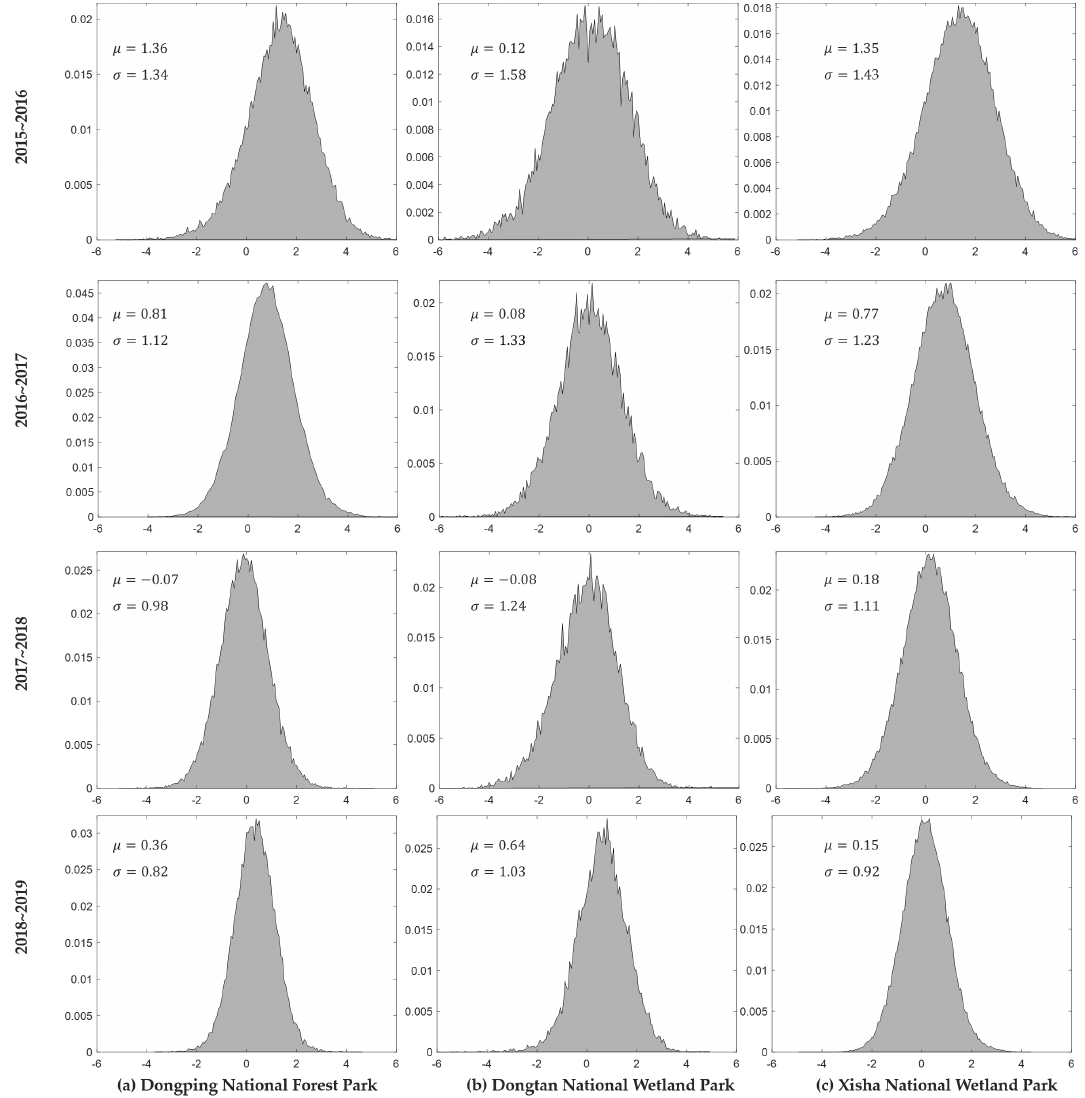
Figure 10. This figure shows the distributions of the ratio images with statistical parameters using VH band from 2015 to 2019. As the time series SAR images are in logarithmic scale, subtraction was performed for image rationing, producing negative or positive mean µ . A positive mean value can used to indicate an increase in forest area, and vice versa. 2015 ∼ 2016 denotes that the image rationing are performed on the two images collected from 2015 and 2016,